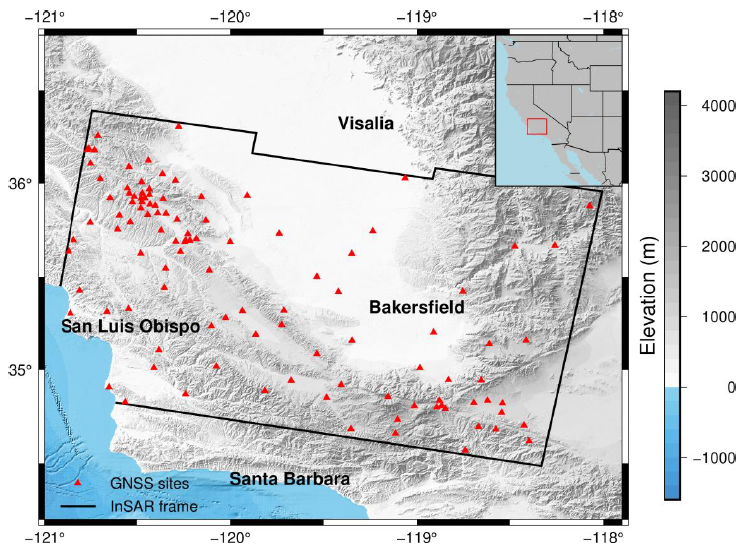
Figure 3. Topographic and spatial distribution of global navigation satellite system (GNSS) sites (red triangles) and interferometric synthetic aperture radar (InSAR) data (black lines) covering the central valley aquifer system (CVAS). The red box in the upper right inset depicts the study area. In order to evaluate the accuracy of the GInSAR processing results, after the GNSS displacement is transferred to the LOS direction of InSAR, the error RMS value between GNSS and the GInSAR result is calculated and plotted in Figure 4.